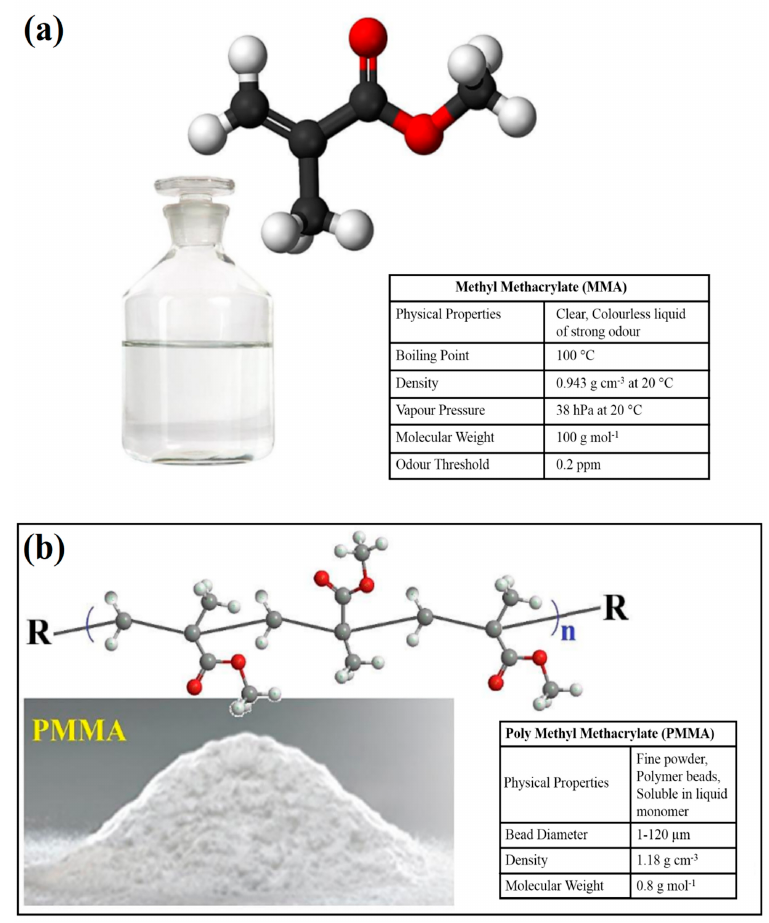
Figure 2. Chemical structures and properties of ( a ) MMA and ( b ) PMMA [11].